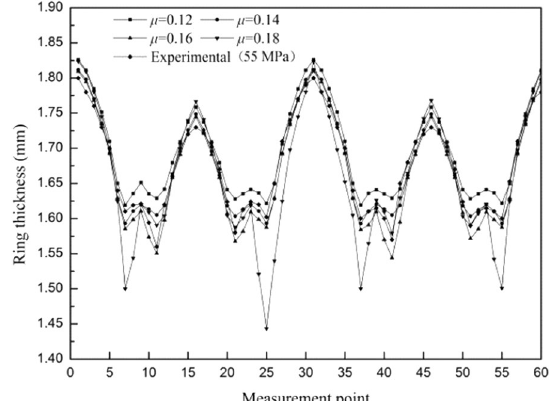
Figure 17 Comparison between the simulation results and experimental results for wall